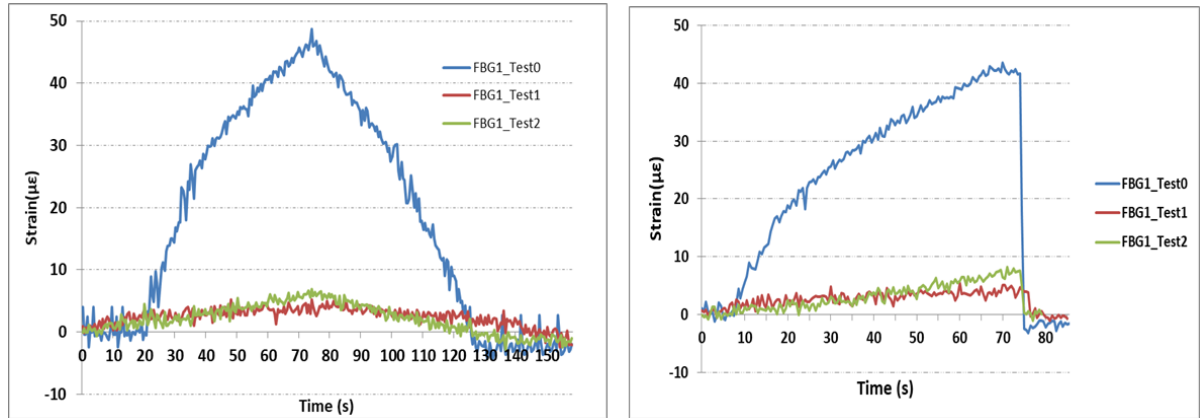
Figure 11. Strain measurements from FBG1 sensor. Left : Strain measurements from the test profile of gradual changes; Right : Strain measurements from the test profile of sudden changes.